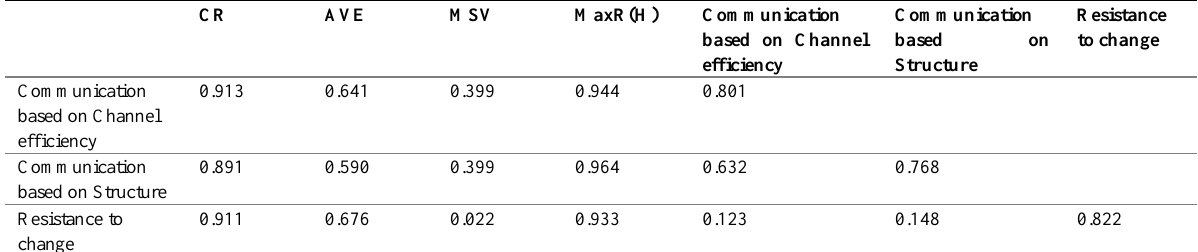
Table 3 : Composite reliability, average variance extracted, and maximum shared square values